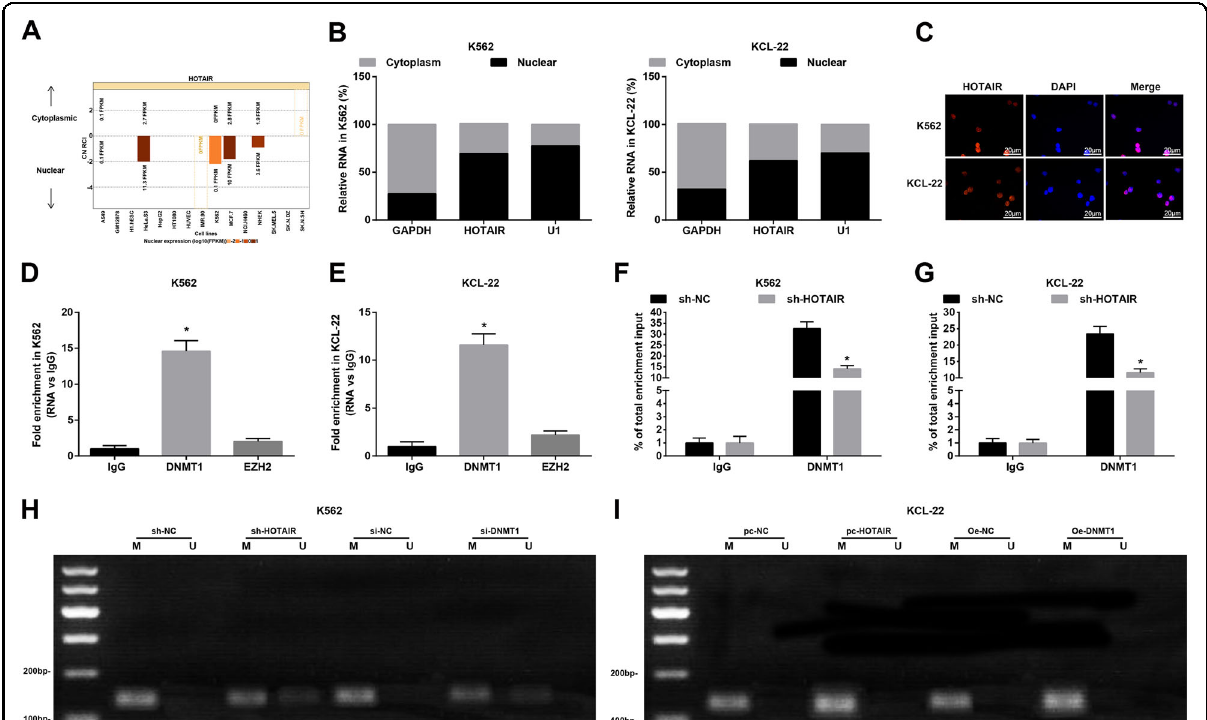
Fig. 5 HOTAIR binds to DNMT1 to regulate PTEN methylation. A HOTAIR subcellular localization predicted by online analysis site. B HOTAIR distribution in K562 cells and KCL-22 c ells. C HOTAIR distribution in K562 cells and KCL-22 cells veri fi ed by FISH assay. D HOTAIR binds to methyltransferase in K562 cells tested by RIP assay. E HOTAIR binds to methyltransferase in KCL-22 cells tested by RIP assay. F The binding of DNMT1 and PTEN in K562 cells tested by ChIP assay. G The binding of DNMT1 and PTEN in KCL-22 cells tested by ChIP assay. H PTEN methylation level in K562 ce lls tested by MSP. I PTEN methylation level in KCL-22 cells tested by MSP. In RIP assay, * P < 0.05 vs. the IgG group. In ChIP assay, * P < 0.05 vs. the sh-NC group. N = 3. Measurement data were depicted as mean ± standard deviation. Comparisons between two groups were conducted